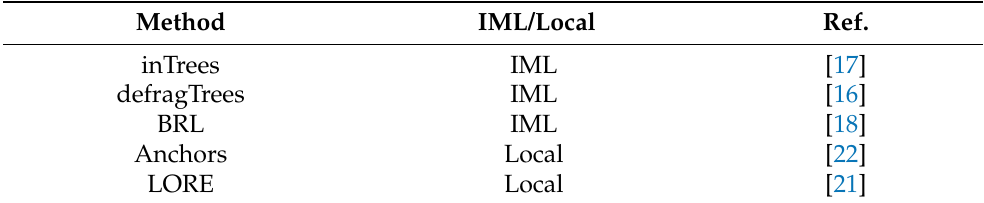
Table 2. Methods used in the